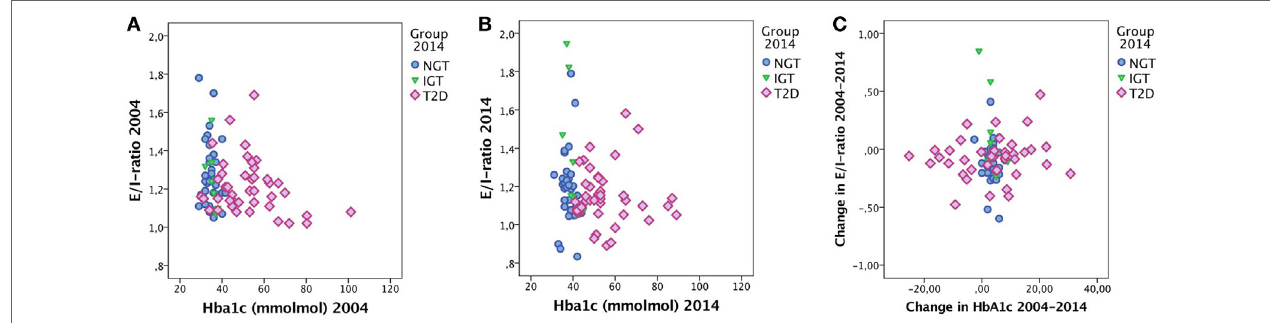
FigUre 2 | E / I ratio and HbA1c in (a) 2004 and (B) 2014 and (c) the change in E / I ratio over time vs. the change in HbA1c over time. Cases labeled by groups [normal glucose tolerance (NGT), impaired glucose tolerance (IGT), and type 2 diabetes (T2D)].